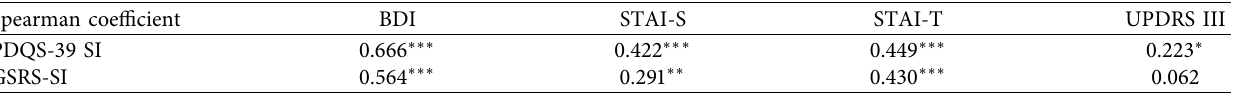
Table 3: Spearman correlations (pairwise) of BDI, STAI-S, STAI-T, and UPDRS III with GSRS SI and PDQ-39 SI total scores. Spearman